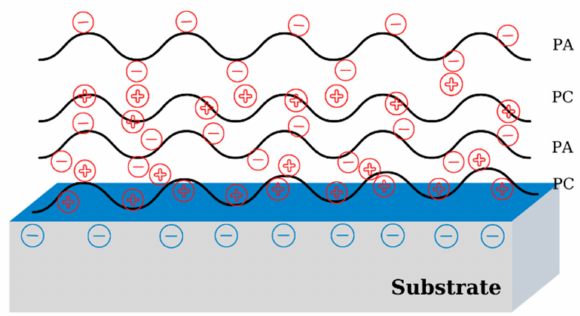
Figure 2. Schematic representation of a polyelectrolyte